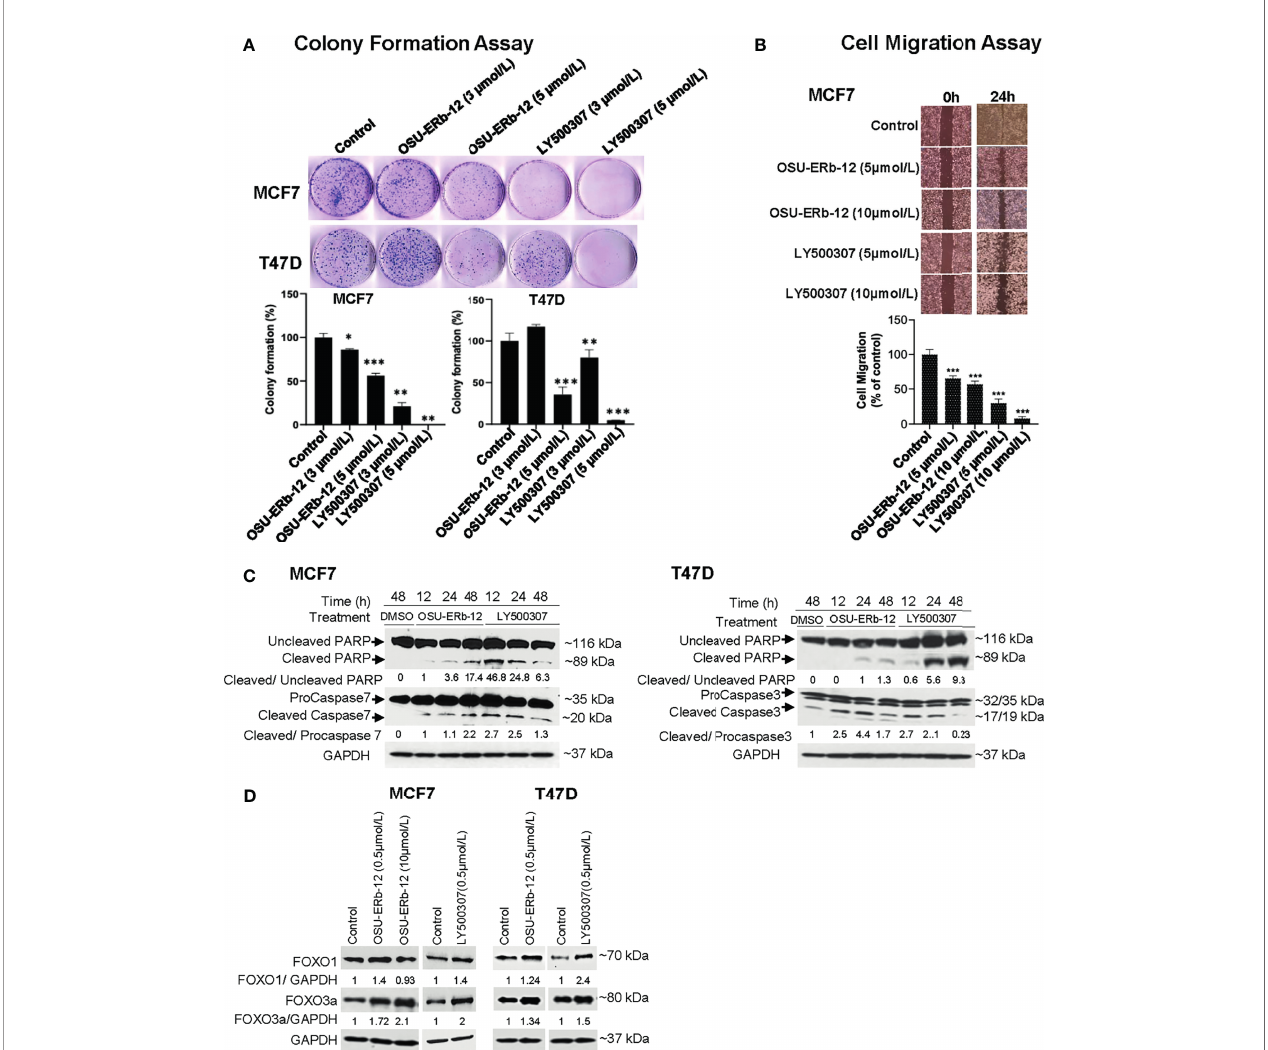
FIGURE 5 | Treatment with ER b -speci fi c agonists OSU-ERb-129 and LY500307 promotes anticancer effects in ER a + breast cancer lines in vitro . (A) Colony formation. Colonies were stained with crystal violet and counted. The percentage of colonies present in each treatment is shown relative to DMSO vehicle-treated controls. Data are from three independent experiments and presented as mean ± SD; *p < 0.05, **p < 0.01, ***p < 0.001; n = 3. (B) Cell migration. Cell migration was determined using the wound-healing assay. The percentage of the fi lled area is calculated, normalized to DMSO-treated control, and presented as mean ± SD from three independent experiments; mean ± SD; *p < 0.05, **p < 0.01, ***p < 0.001; n = 3. (C) Enhanced cleavage of PARP-1, and activation of caspases 3 and 7 in ER a + breast cancer cells upon treatment with ER b agonists. Western blot analyses were performed using speci fi c antibodies in whole-cell lysates prepared from OSU-ERb-12- and LY500307-treated cells as indicated. Similar results were obtained in different batches of cells treated with OSU-ERb-12 and LY500307. Numbers under the lanes are the quantitative representation of the intensity of the normalized bands. The signal in each band was quanti fi ed using Image Studio (LiCor) software. (D) Enhanced expression of FOXO1 and FOXO3a proteins in ER a + breast cancer cells upon treatment with ER b agonists. Western blot analyses were performed using speci fi c antibodies in whole cell lysates prepared from cells treated for 7 days with OSU-ERb-12 or LY500307. Similar results were obtained with different batches of cells treated with OSU-ERb-12 or LY500307. Numbers under the lanes represent corresponding normalized band intensity of the respective proteins. Image Studio (LiCor) software was used to quantify the intensity of the protein